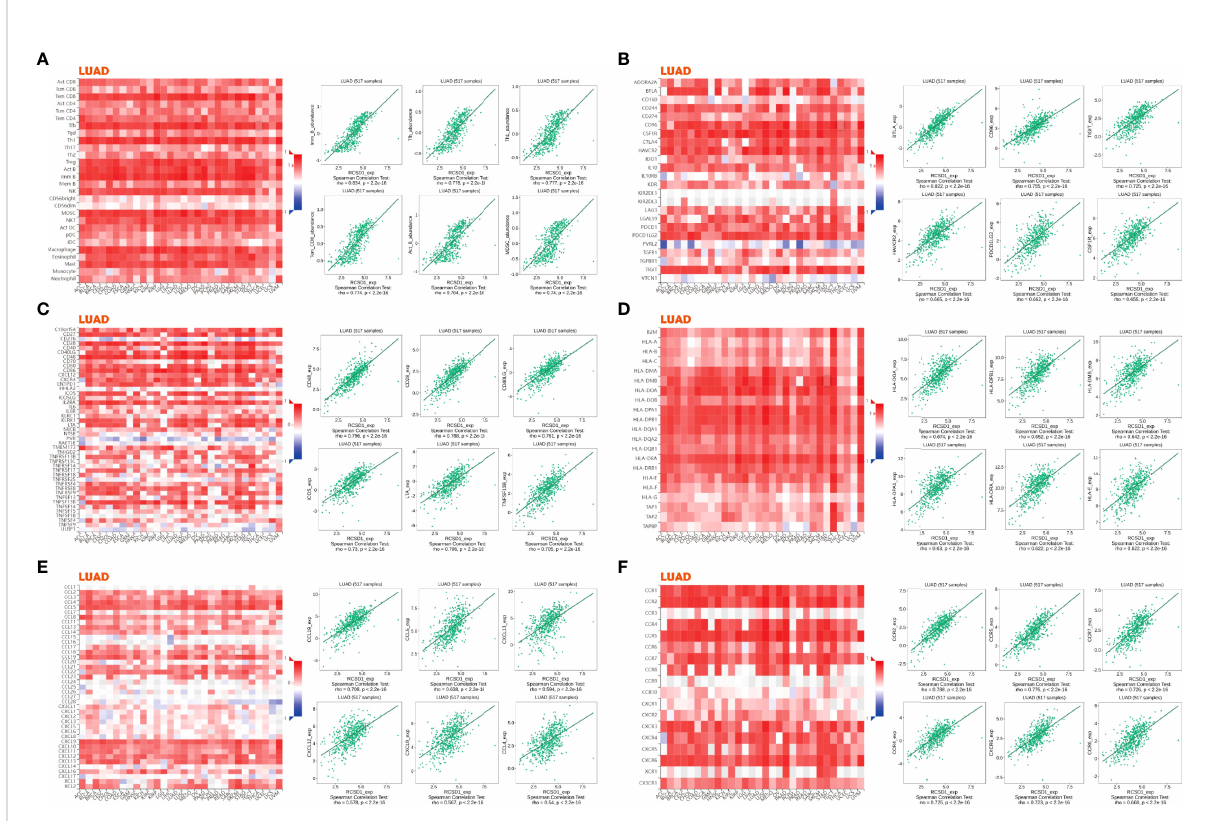
FIGURE 11 Associations of the RCSD1 expression level with lymphocytes, immunomodulators and chemokines in LUAD. (A) Correlations between abundance of tumor-in fi ltrating lymphocytes (TILs) and RCSD1 (plus the six TILs with the highest correlation). (B – D) Correlations between immunomodulators and RCSD1 (plus the six immunomodulators with the highest correlation, respectively). (E, F) Correlations between chemokines (or receptors) and RCSD1 [plus the six chemokines (or receptors) with the highest correlation,